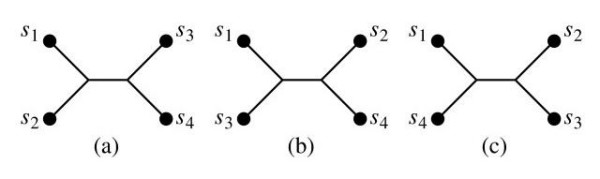
The three possible quartet topologies for quartet {s1, s2, s3, s4}.